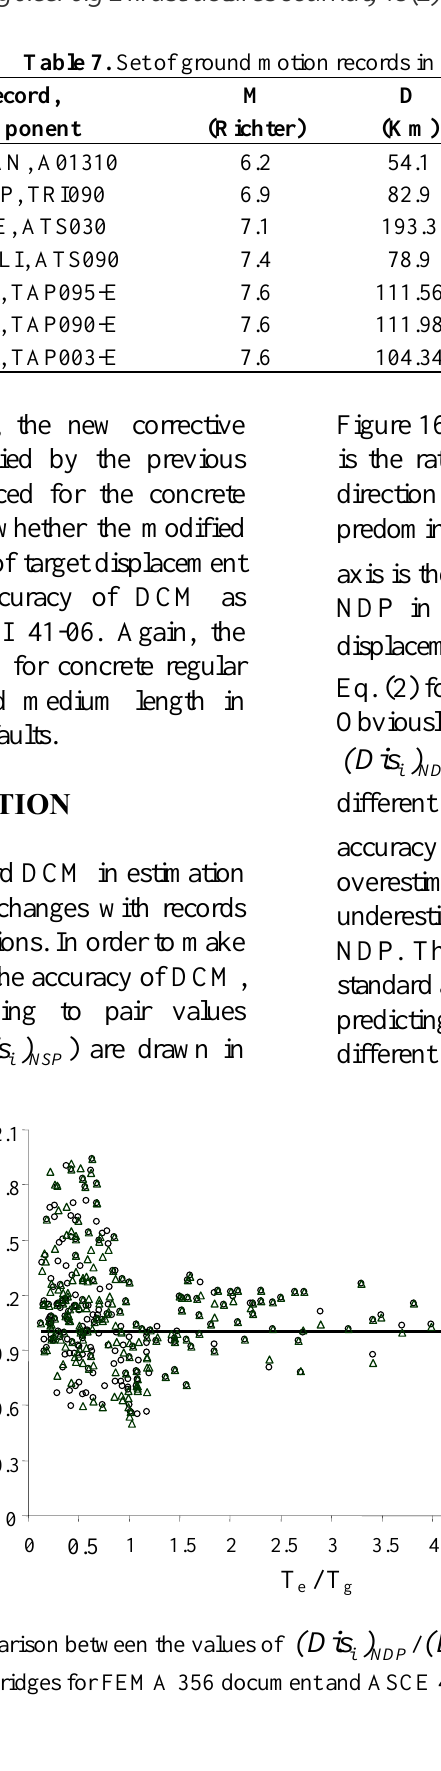
Fig. 16. The general comparison between the values of bridges for FEMA 356 document and ASCE 41-06